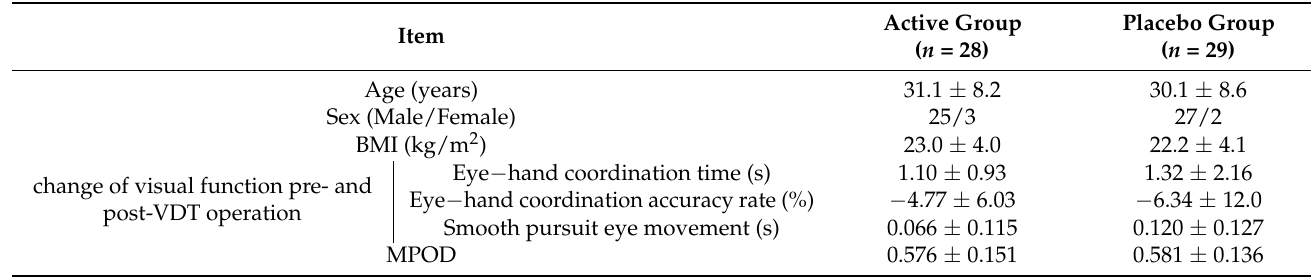
Table 2. Baseline characteristics of the participants who completed the eight-week study.